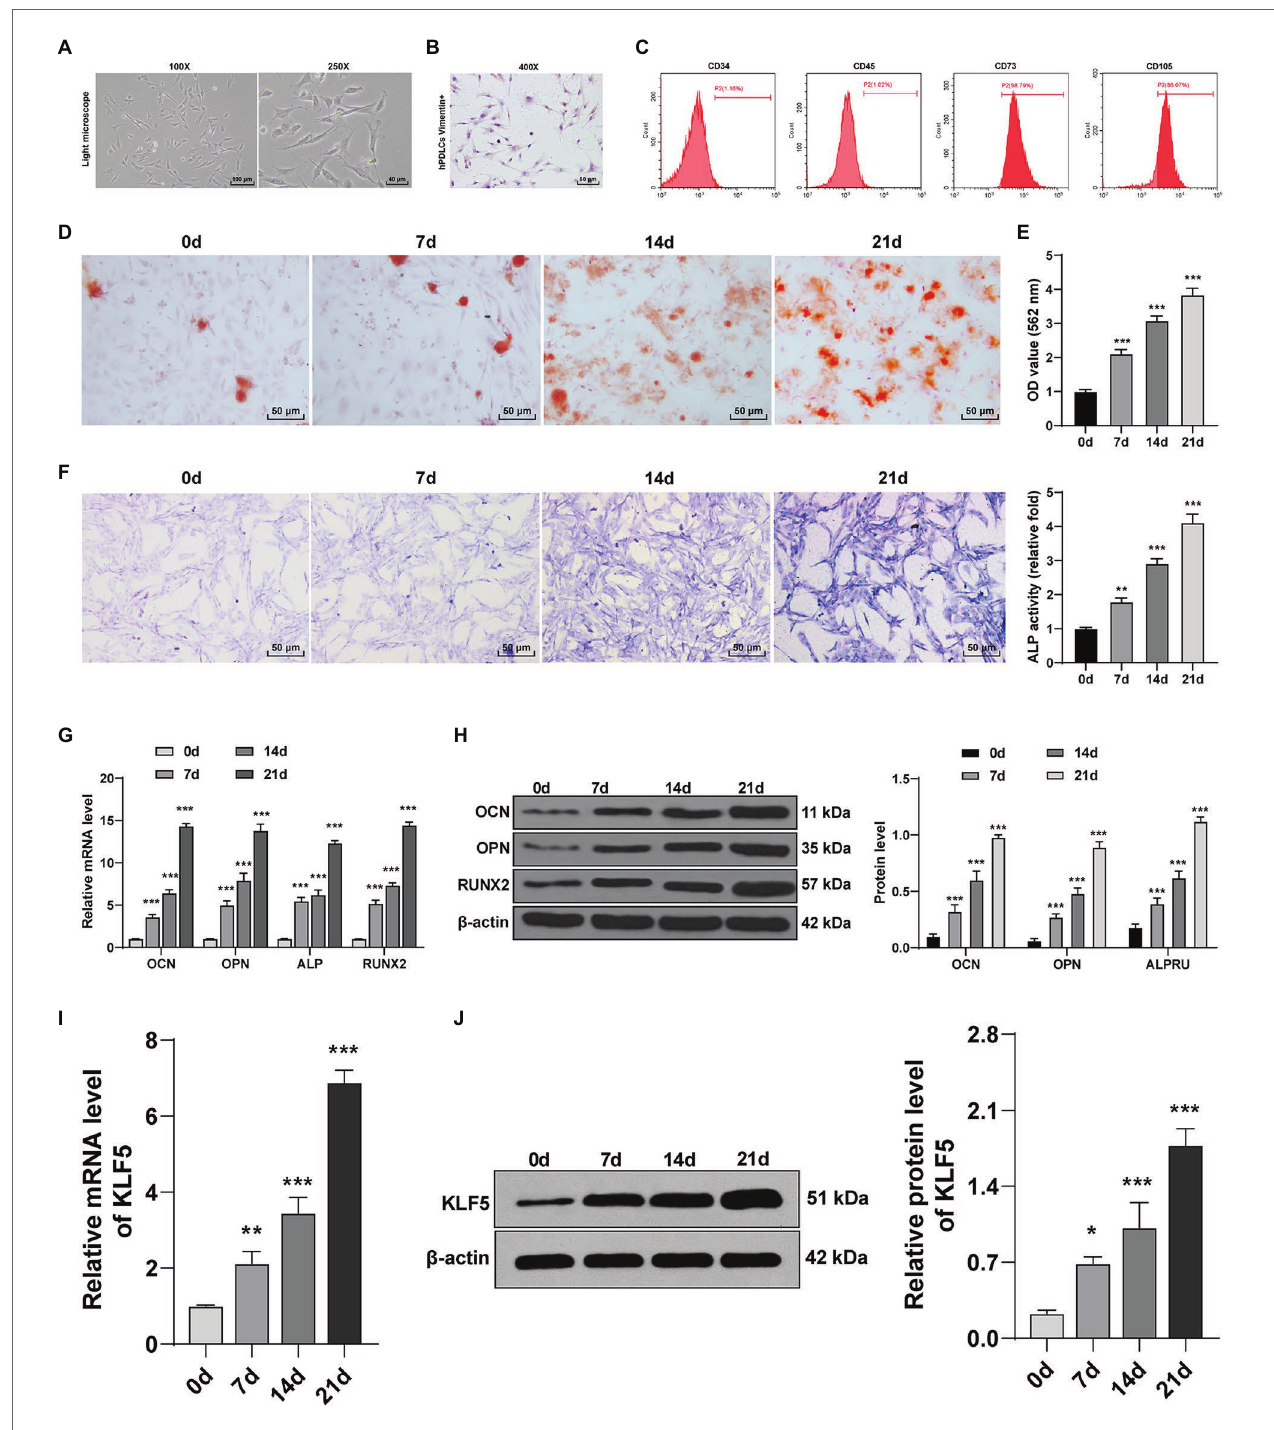
FIGURE 1 | KLF5 expression was upregulated during osteogenic differentiation of hPDLCs. (A) Morphology of hPDLCs at passage 3. (B) Vimentin was measured using immunohistochemistry staining (400×, bar = 40 μ m). (C) Expressions of surface markers of hPDLCs were identified using flow cytometry. (D,E) Osteogenic differentiation of hPDLCs was analyzed using ARS staining and ARS semi-quantitative analysis. (F) ALP activity was measured using ALP staining. (G,H) Levels of osteogenic specific markers (OCN, OPN, ALP, and Runx2) were detected using Reverse transcription quantitative polymerase chain reaction (RT-qPCR) and Western blotting. (I,J) KLF5 expression during the osteogenic differentiation of hPDLCs was detected using RT-qPCR and Western blotting. The experiment was repeated three times. Data are expressed as mean ± standard deviation. One-way ANOVA was applied to assess data in panels (E,F,I,J) , and two-way ANOVA was applied to assess data in panels (G,H) , followed by Dunnett’s multiple comparisons test or Tukey’s multiple comparisons test, * p < 0.05, ** p < 0.01, *** p <